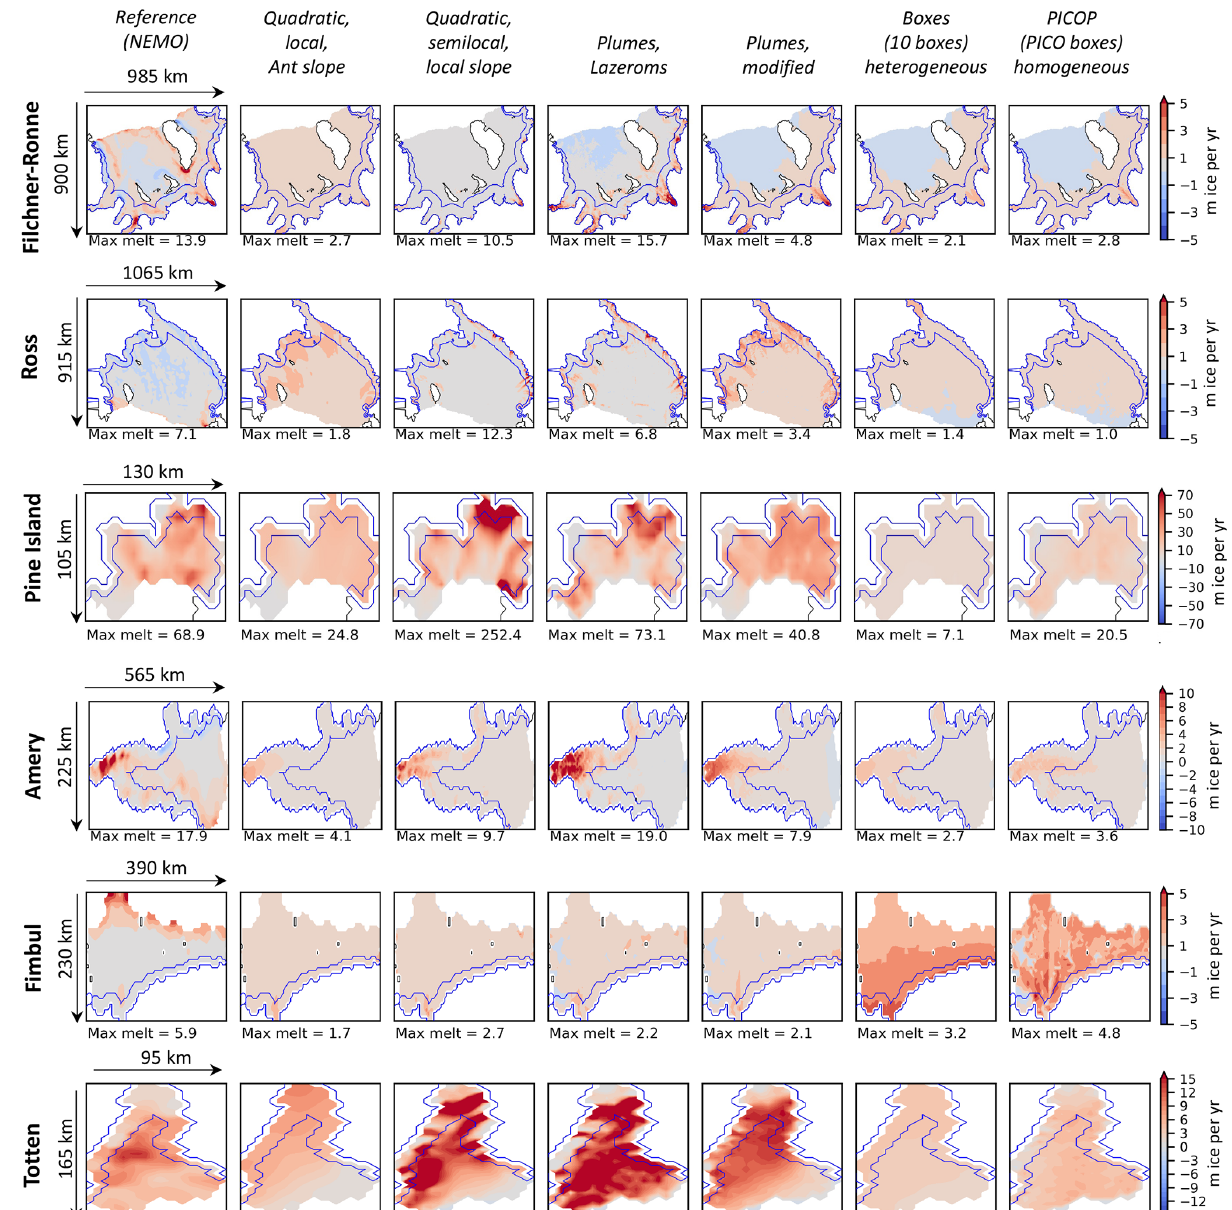
Figure 6. Subset of ice shelves for a visual evaluation of the melt patterns. The parameterised melt rates are computed using the best-estimate parameters given in Tables 4, 6, 8, and 10. This is the time average for the REALISTIC run (39 years). The blue line indicates the region used to evaluate the melt rate near the grounding line (which is defined as the first box in the five-box setup of the box parameterisation). “Ant slope” stands for “Antarctic